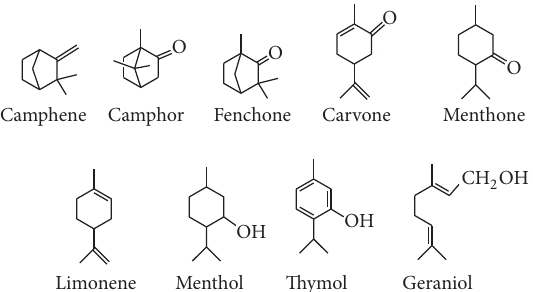
Figure 1: Chemical structures of pure tested monoterpenes.